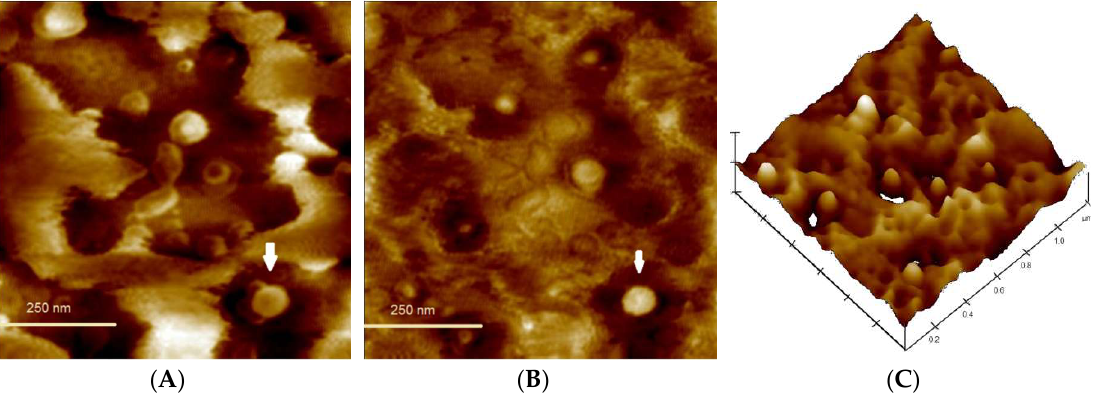
Figure 7. Phase ( A ) and height ( B , C ) 3D contrast images of Capt(0.5)-Zn(25)-MLNC-Fur(0.45). Sample was deposited on mica, left to completely dry and, then, analyzed by tapping mode of 1 × 1 μm² area, which was scanned with 256 points at 0.5003 Hz speed and range ( z -axis) of 50 nm, in air at room temperature (23 °C).